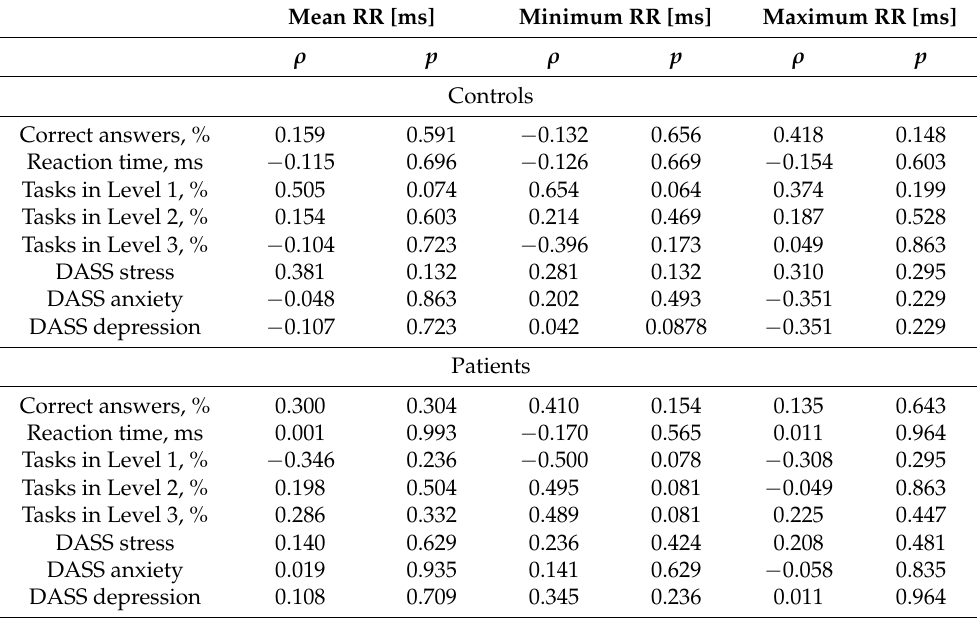
Table 3. Results of the correlation analysis between the ECG-derived parameters and performance and psychological variables in patients and controls during